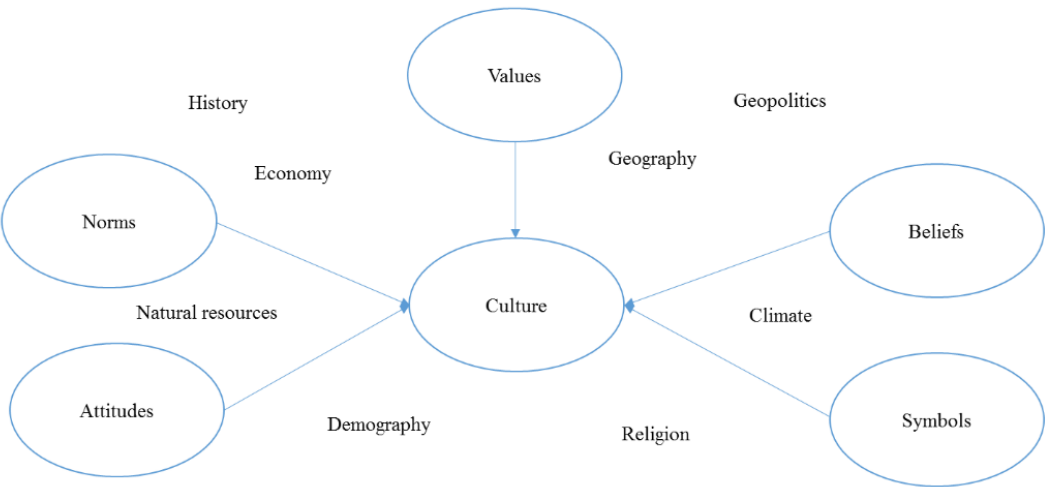
Figure 1. Construction and elements of culture (Source: Author). Blue ovals are elements of culture and factors that explicitly or implicitly affect all elements of culture are in the background.